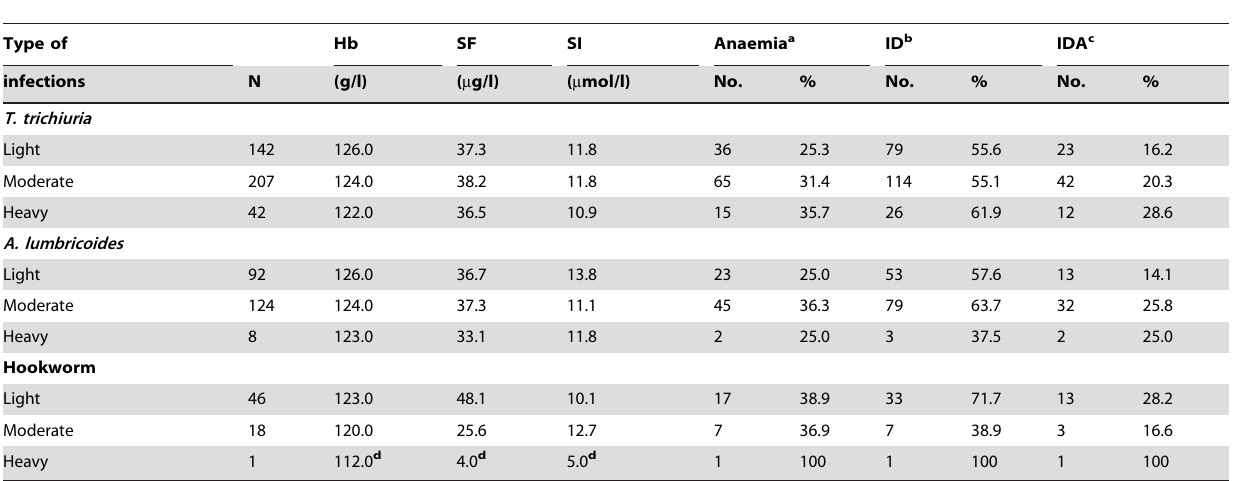
Table 3. Distribution of anaemia, iron deficiency and iron deficiency anaemia according to intensity of STH infections.